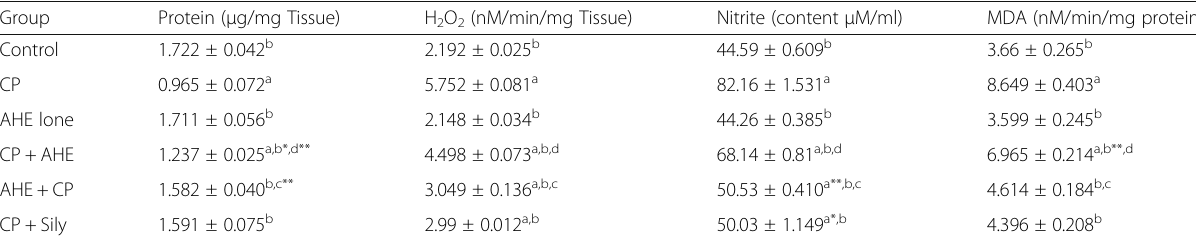
Table 4 Effect of cisplatin (CP) and different treatments of AHE on lung tissue protein, oxidative stress markers and lipid